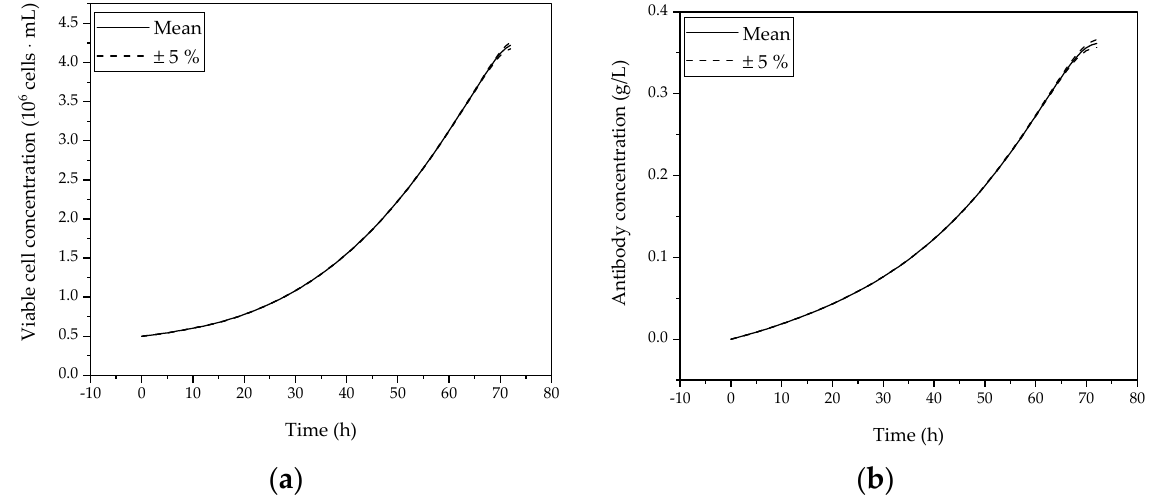
Figure 9. Monte Carlo Simulations using the Optimal Operating Point (derived from DoE) for initial substrate concentrations with a standard deviation of ± 5%. ( a ) Viable cell concentration during initial batch phase, ( b ) mAb